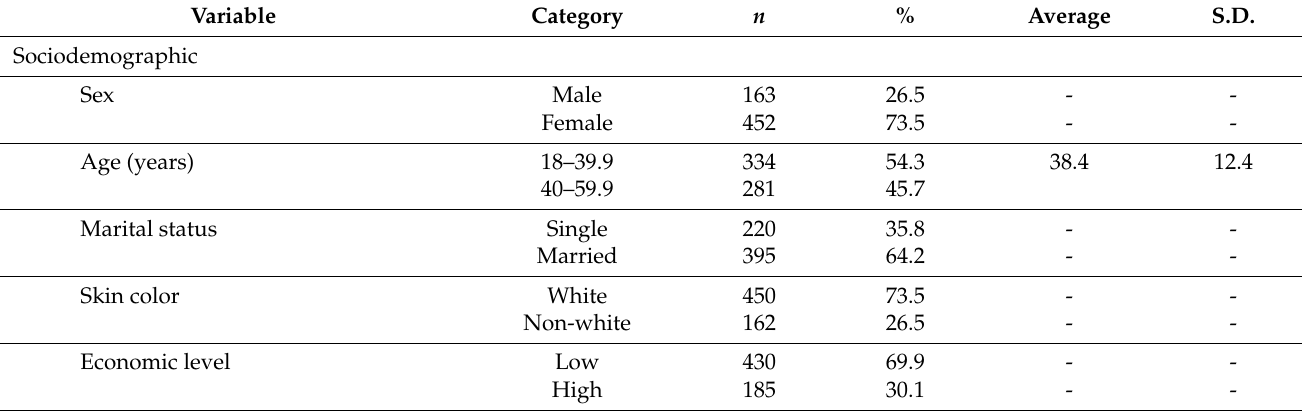
Table 1. Sample characteristics of adults in primary health care. S ã o Jos é dos Pinhais, Southern Brazil, 2019 ( n =